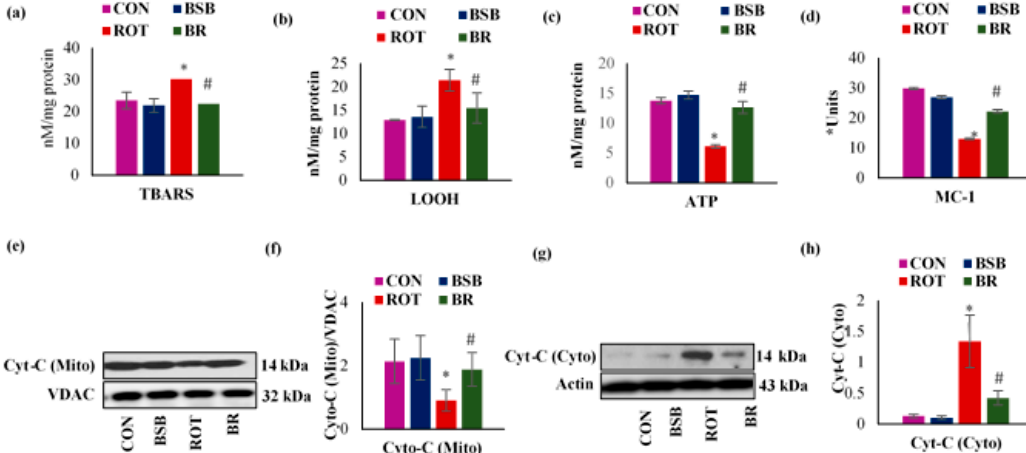
Figure 9. Concentrations of TBARS ( a ) and LOOH ( b ) in the mitochondrial fraction of striatum. Levels of ATP in the mitochondrial fraction of striatum ( c ) and e ff ect of BSB on MC-I activity in the mitochondrial fraction of striatum ( d ). ROT-injected rats showed a significant decrease in the activity of MC-1 when compared to control rats (CON). In contrast, BSB treatment to ROT injected rats significantly restored the activity of MC-I (*Units-nM of NADH oxidized / min / mg protein) ( d ). Mitochondrial and cytosolic protein expression of cytochrome-C in the striatum and the densitometric analysis ( e – h ). ROT-injected rats showed a significant decrease in the expression of mitochondrial cytochrome-C with significant increase in the expressions of cytosolic cytochrome-C compared to control rats (CON). In contrast, BSB treatment to ROT injected rats significantly restored the expression of cytochrome-C compared to ROT alone injected rats. The values are expressed as mean ± SEM (n = 3). * p < 0.05 CON vs. ROT; # p < 0.05 ROT vs. BR (One-way ANOVA followed by DMRT).